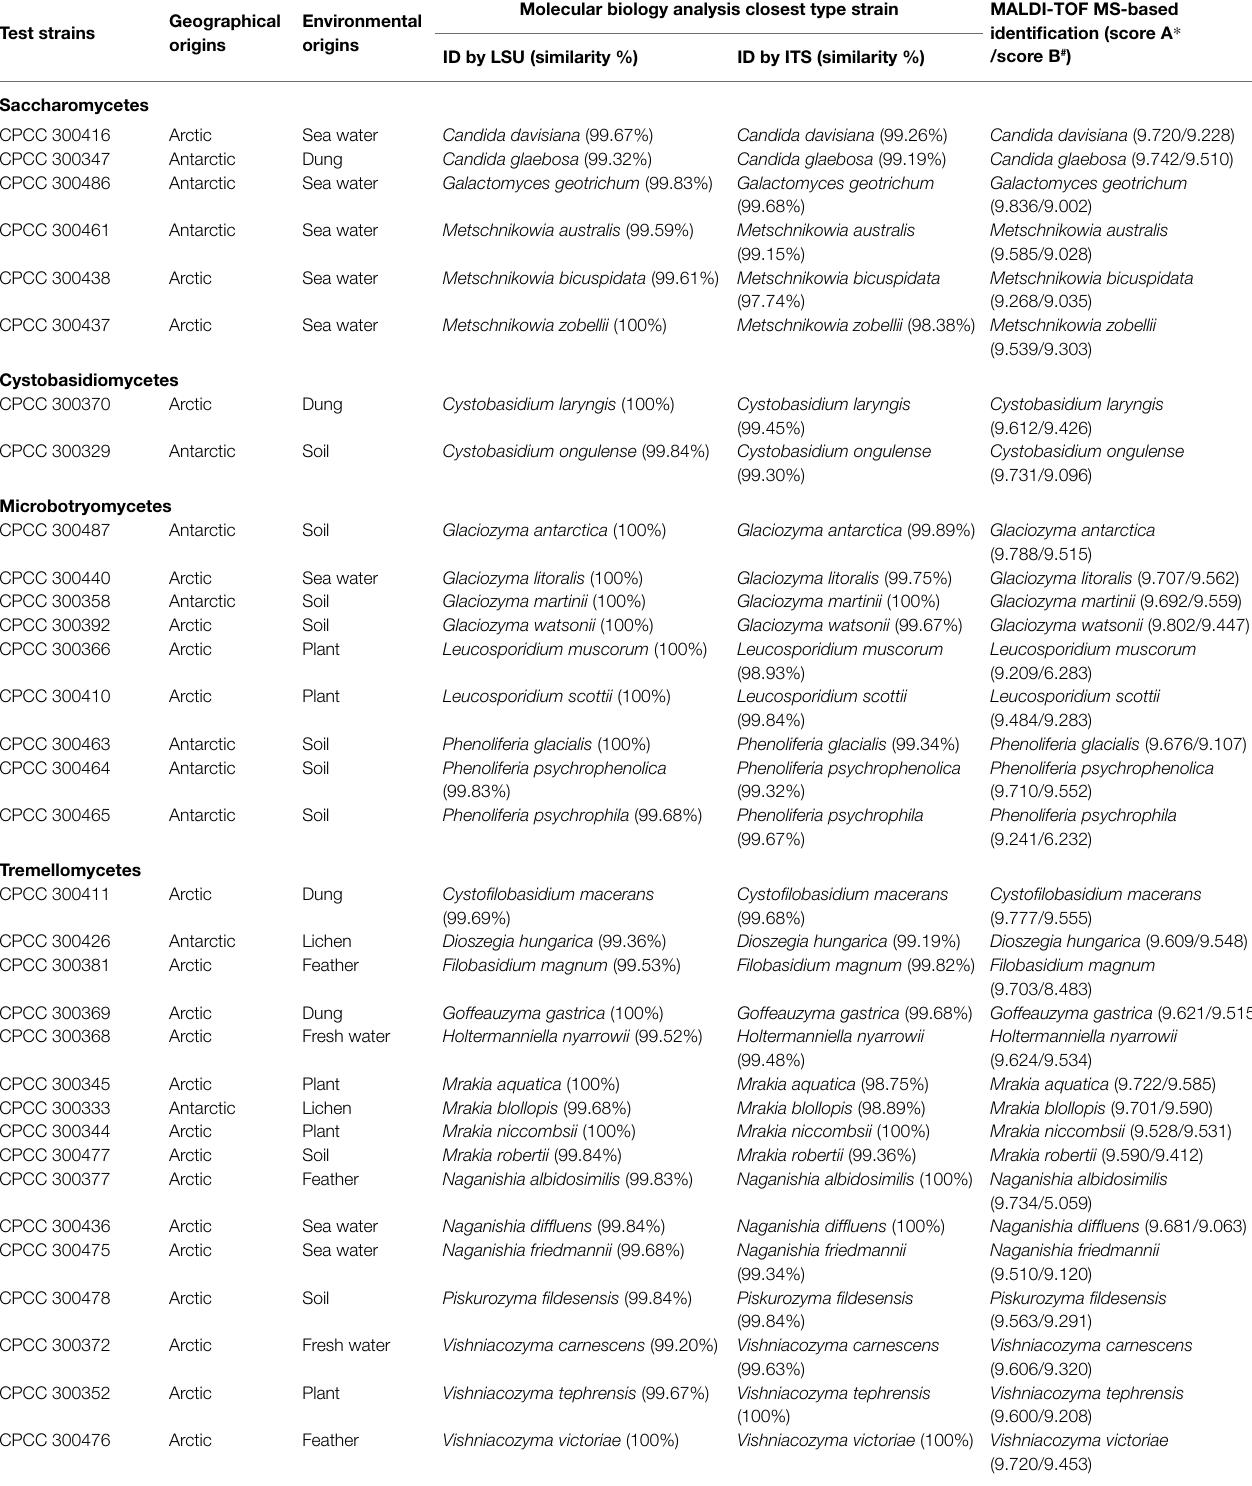
TABLE 1 | Information on the origins of the 33 polar yeast species and results of molecular identification and matrix-assisted laser desorption/ionization time-of-flight mass spectrometry (MALDI-TOF MS)-based identification.